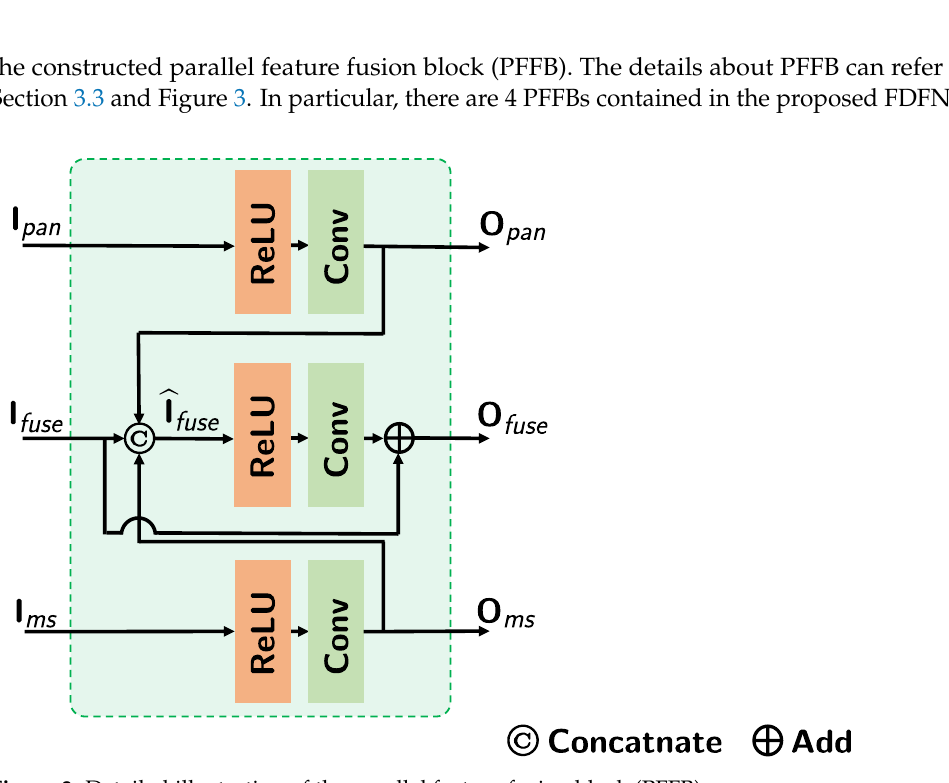
Figure 3. Detailed illustration of the parallel feature fusion block